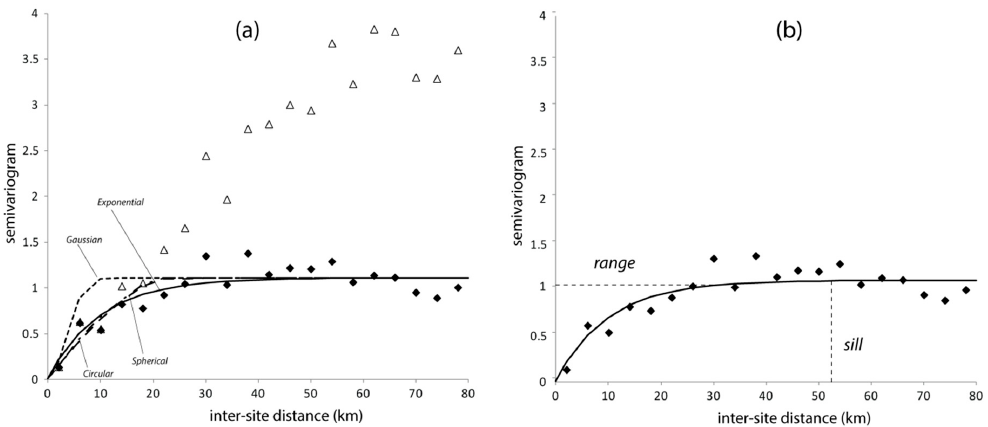
Figure 3. Example of empirical semivariogram: original values together detrended ones and fitted models ( a ); detail on parameters for fitting a model ( b ).